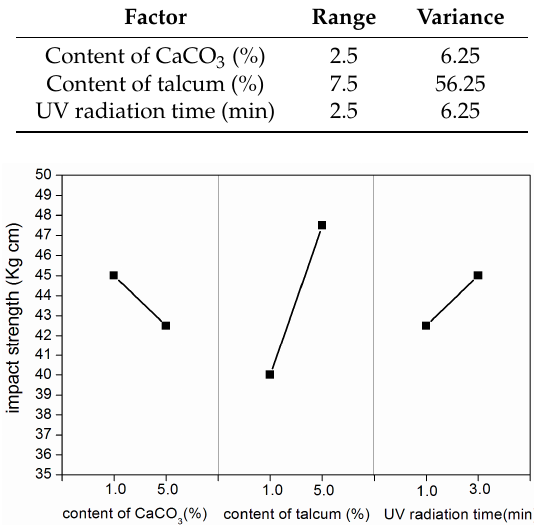
Figure 1. Main effects plot of CaCO 3 , talcum content and ultraviolet (UV) irradiation time (sample 1–4 in Table 2). Table 4. Interactions of talcum and CaCO 3 . Table 4. Interactions of talcum and CaCO